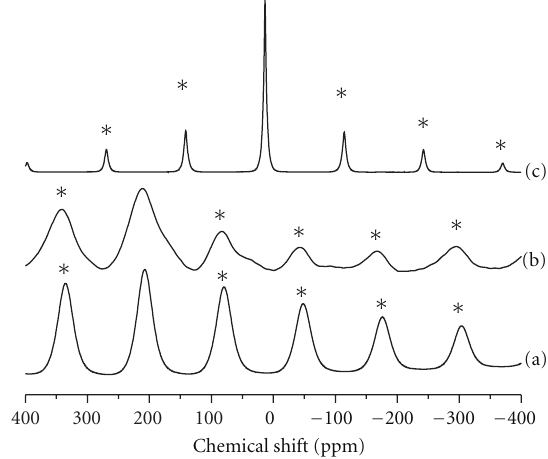
Figure 2: 27 Al MAS NMR spectra of EuAlO 3 , La 0 . 30 Eu 0 . 70 AlO 3 , and LaAlO 3 ; (a), (b), and (c), respectively. ∗ indicates spinning side bands.